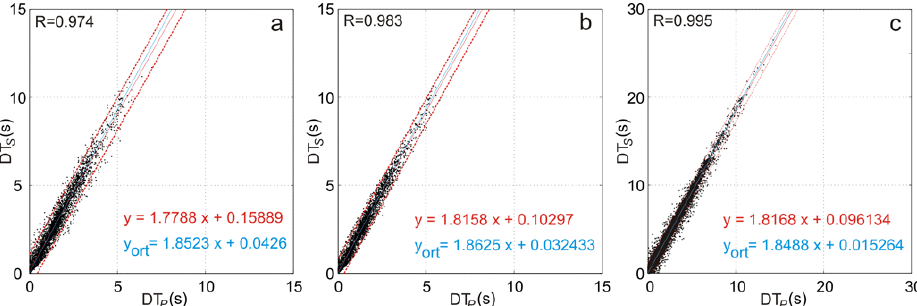
Fig. 5. Modified Wadati plot (Chatelain, 1978) of the arrival time data set of this study. (a) Initial data set of STN stations only. Red and blue lines represent ordinary least-squares (with its standard deviation) and orthogonal regression, respectively. Coefficients are given in the formula. (b) The same as (a) but after reading refinement and outlier removal. (c) Final diagram obtained after integration of other stations phase readings (either re-picked or as given by bulletins). Note the increase of linear correlation coefficient R from (a) to (c) , as well as the changes of V P /V S for the two different regressions. The ratio V P /V S 1.85 is the final value